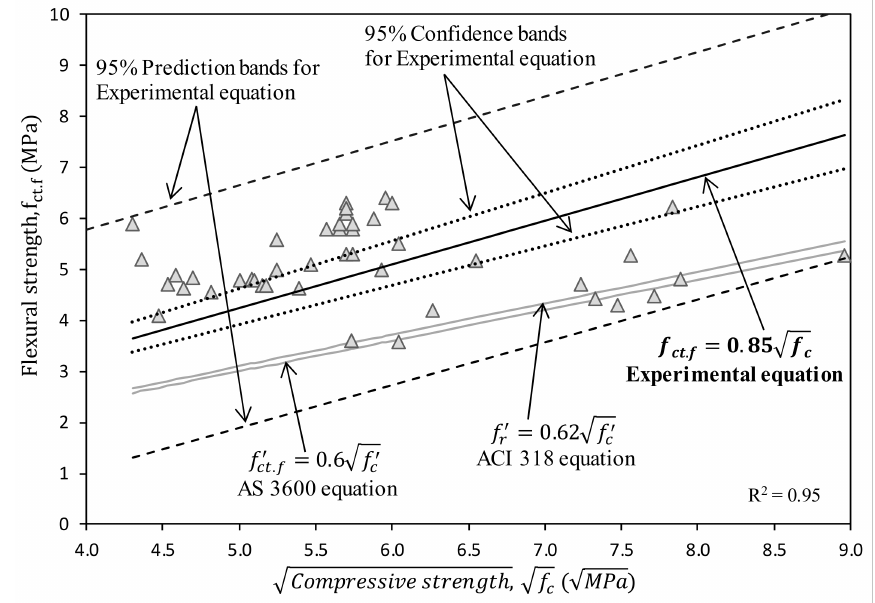
Figure 5. Correlation between compressive strength vs. flexural